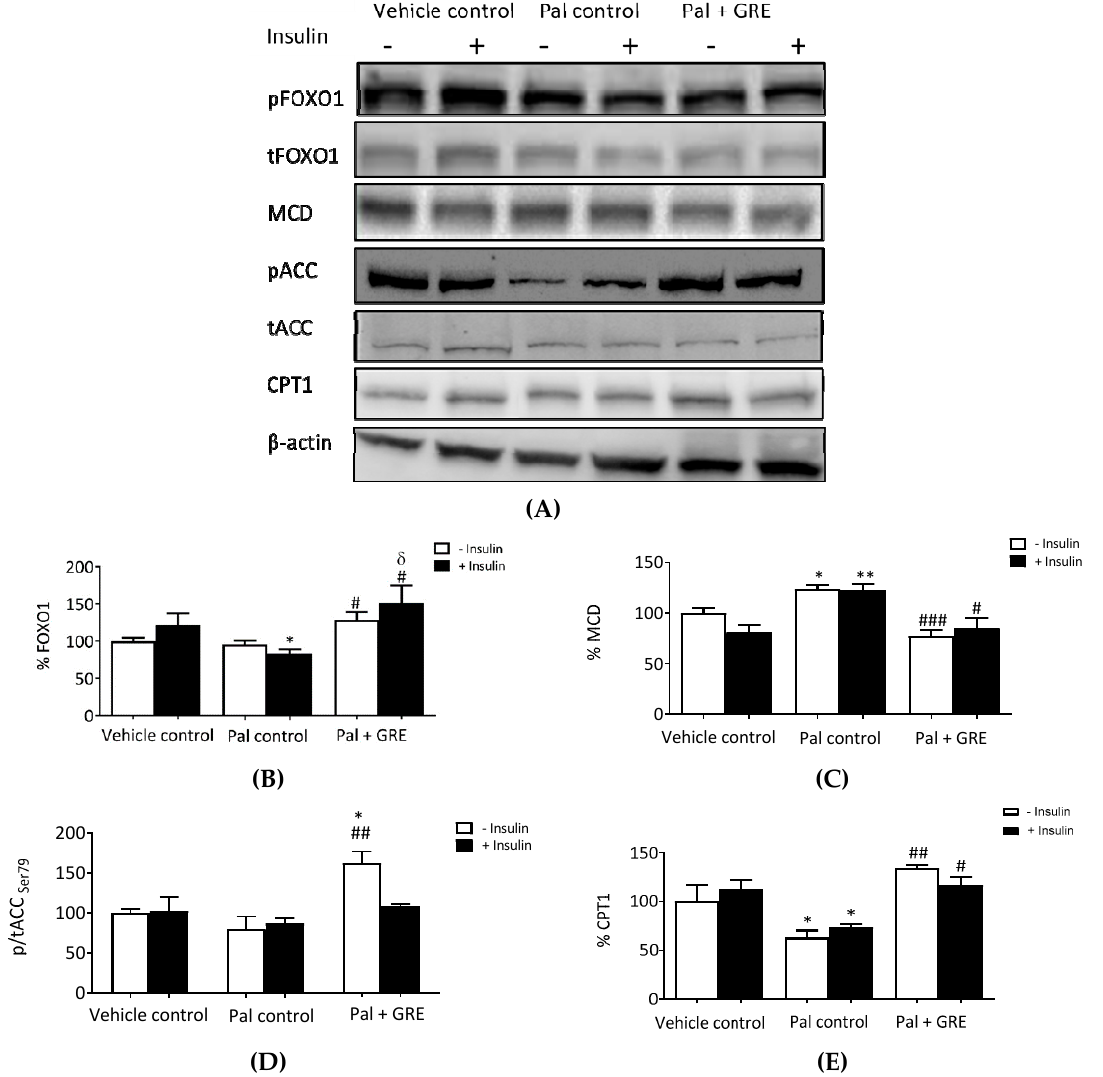
Figure 4. An aspalathin-enriched GRE promoted fatty acid oxidation in palmitate (Pal)-treated C3A cells. Western blot imaging representation ( A ), Western blot analysis of Forkhead box protein O1 (FOXO1) ( B ), malonyl CoA decarboxylase (MCD) ( C ), acetyl CoA carboxylase (ACC) ( D ), and carnitine palmitoyltransferase 1 (CPT1) ( E ). Protein expression results are presented as mean ± SEM of three independent experiments. * p < 0.05, ** p < 0.01 versus vehicle control (no insulin), # p < 0.05, ## p < 0.01, ### p < 0.001 versus Pal control (no insulin). δ p < 0.05 versus insulin-stimulated vehicle control.